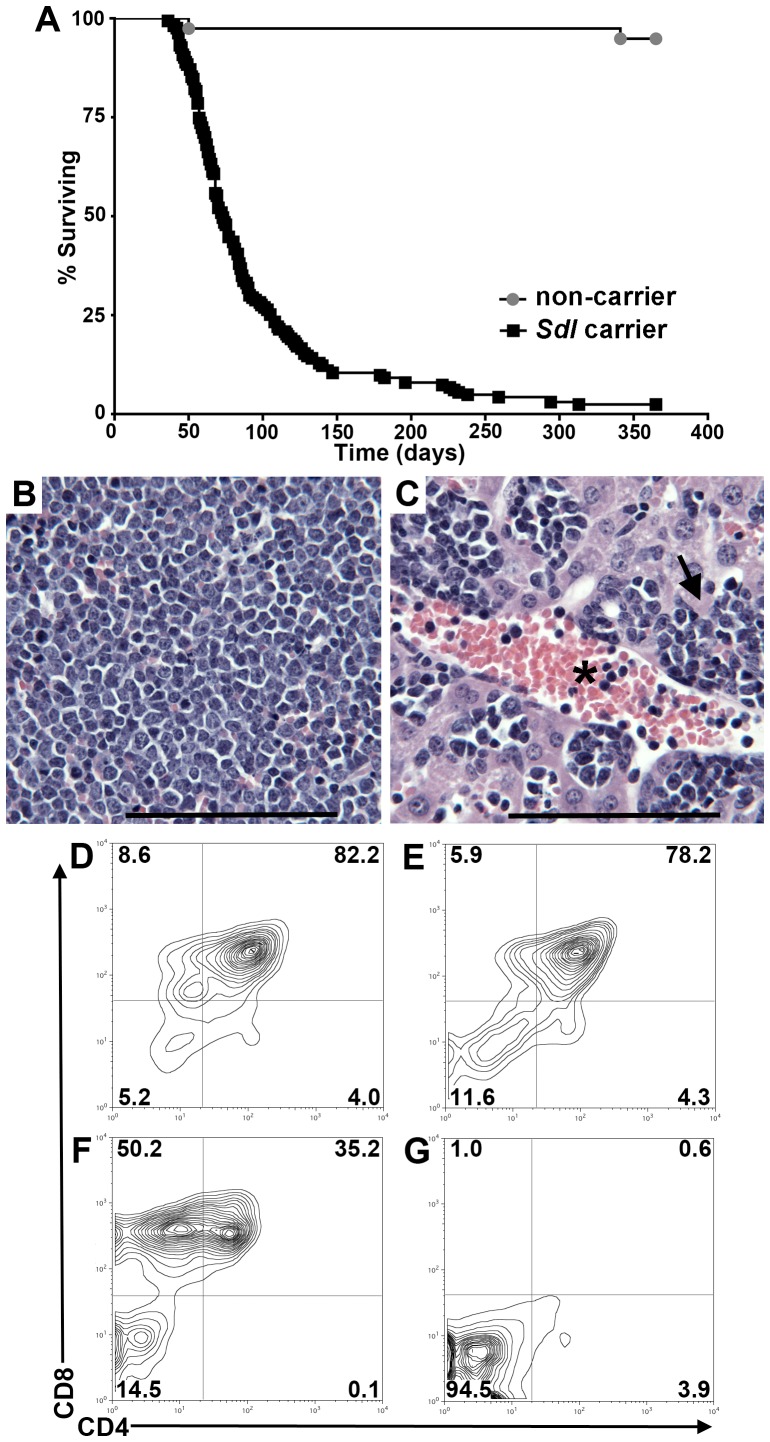
The Sdl mutation results in highly penetrant disease, which is primarily early-onset T-ALL.A) Kaplan-Meier curve of time to morbidity for Sdl mice. Known carriers of Sdl (harboring a C57Bl/6 haplotype at D16MIT131 and D16MIT4 on proximal Chr 16) are denoted by black squares, while sibling non-carriers are denoted by grey circles. p<0.0001. B–C) H&E staining showing that neoplastic cells fill hematopoietic organs (B) and also infiltrate the blood (vessel indicated with an asterisk) and the parenchyma (arrow) of other organs such as liver (C). B and C are 40× magnification, scale bar = 50 µM. D–G) Examples of flow cytometry analysis of lymphomas from four moribund Sdl mice. A full summary of flow-cytometry data is available as Table S1. Mice depicted in D–F succumbed to early onset-disease that is phenotypically T-ALL. Within these animals, there is evidence of both CD4/8 double positive (DP) disease as well as CD8 single positive (SP) disease. The mouse in G became moribund with late-onset disease (354 days of age) and the tumor cells do not express most T cell antigens (see also Table S1).